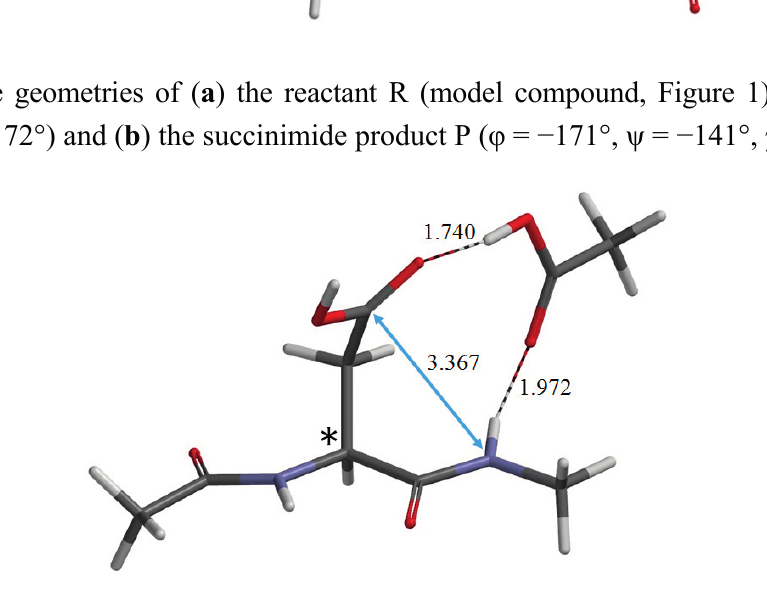
Figure 4. The geometry of the reactant complex R•AA ( φ = − 164°, ψ = − 178°, χ 1 = 76°). The α carbon atom is indicated by an asterisk (*). Selected interatomic distances are shown in Å. The gas-phase total energy of this geometry is − 913.600369 E h